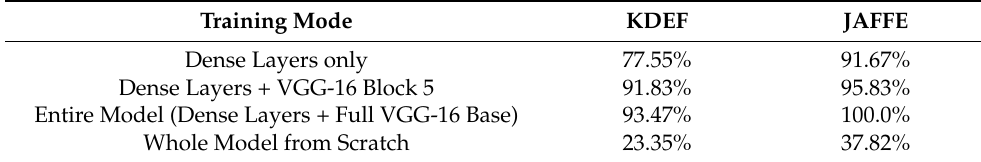
Table 2. Comparison of test set accuracies with VGG-16 for different training modes in fine-tuning.